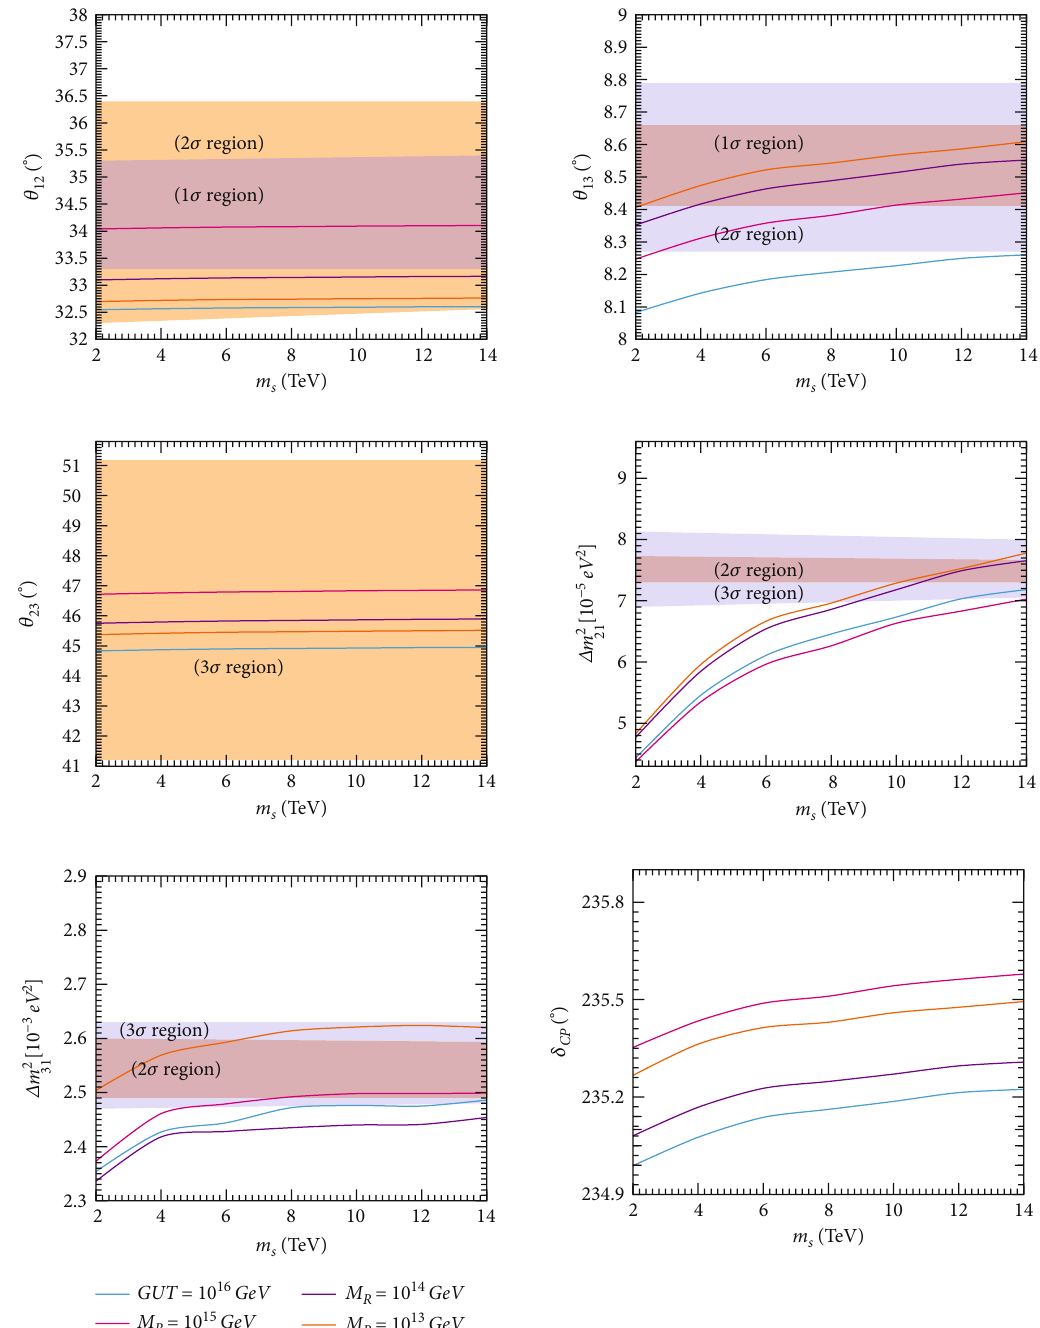
j , and δ , j Δ m 2 with variation of m ij CP ij